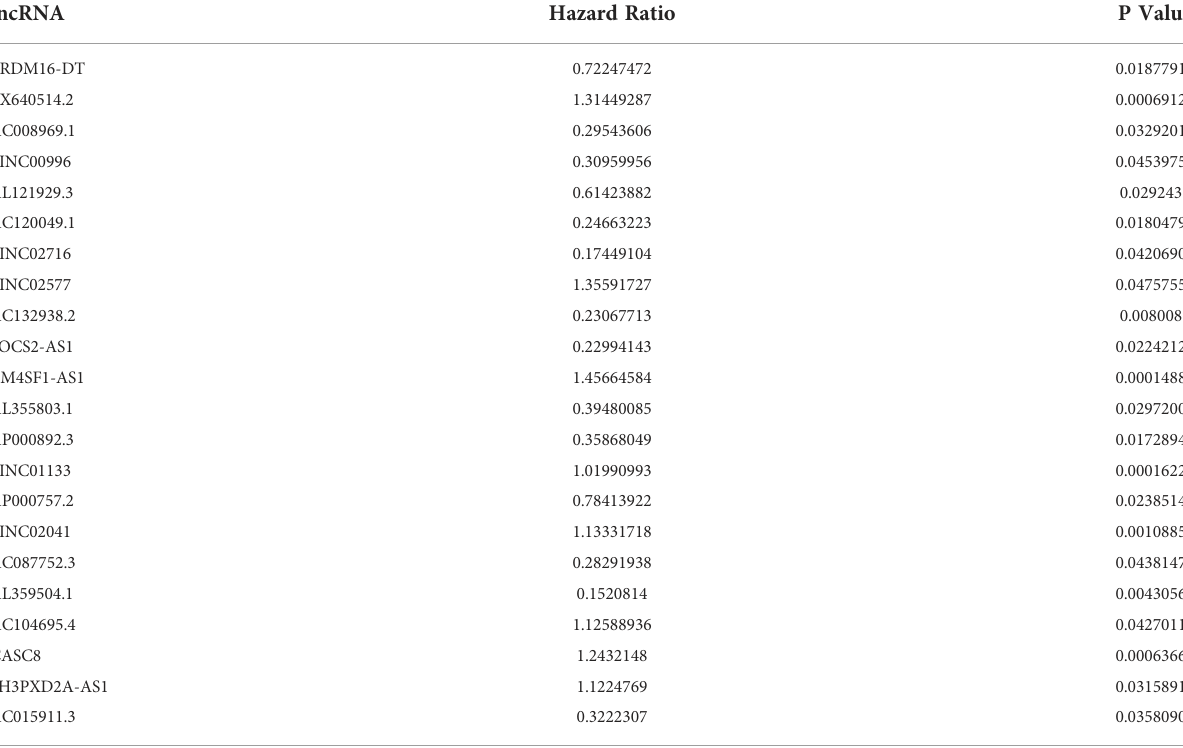
TABLE 2 Univariate Cox proportional hazard regression analysis identi fi ed 22 DE lncRNAs that are signi fi cantly associated with the overall survival of pancreatic cancer